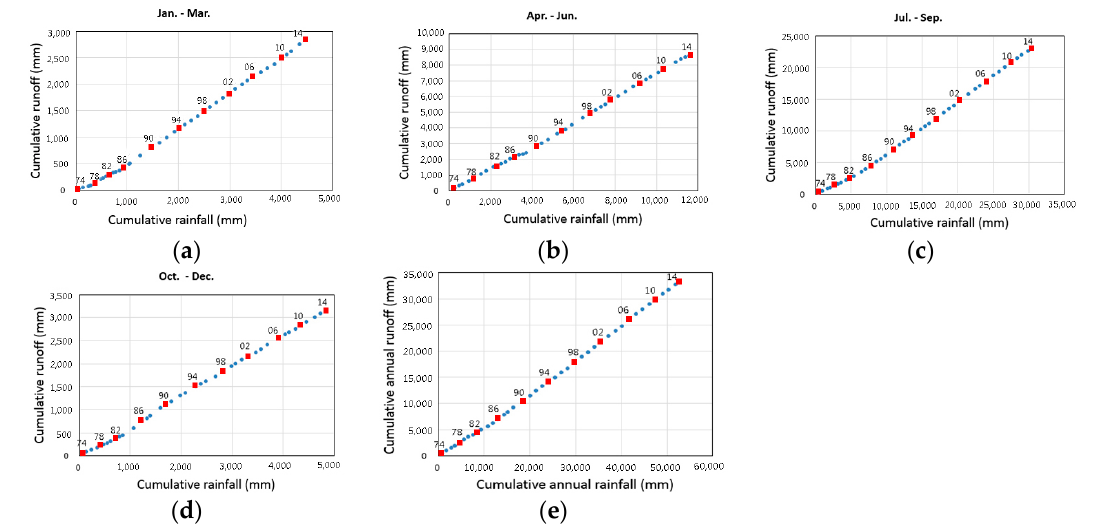
Figure 5. Detection of change point in Soyang Dam upper basin (double mass curve). ( a ) JFM; ( b ) AMJ; ( c ) JAS; ( d ) OND; ( e ) annual. The numbers in figures mean years (e.g., 14 means 2014 year). Water 2017 , 9 , 34